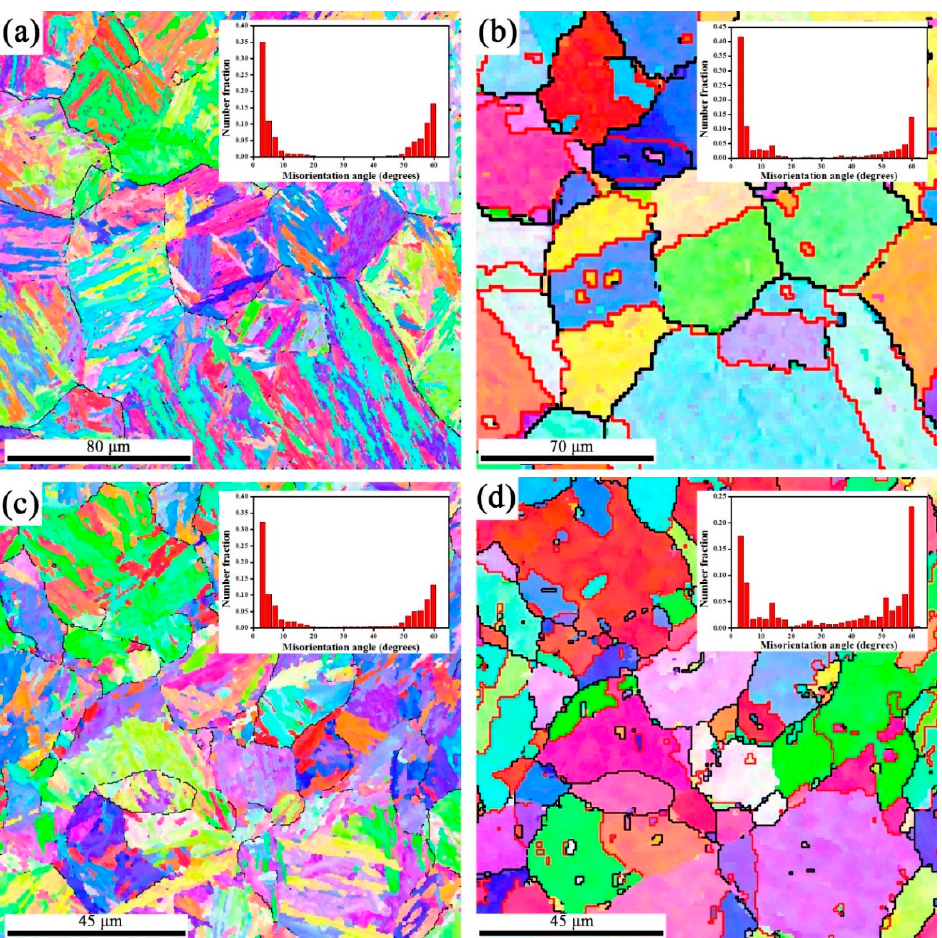
Figure 8. IPF maps with misorientation angle distribution (MAD) charts of α and reconstructed γ deformed at strain rate of 0.01 s − 1 ( a , b ) and 1 s − 1 ( c , d ). (Black lines: misorientation angles > 15 ◦ ; Red lines: Σ3 boundaries in ( b ) and ( d ))